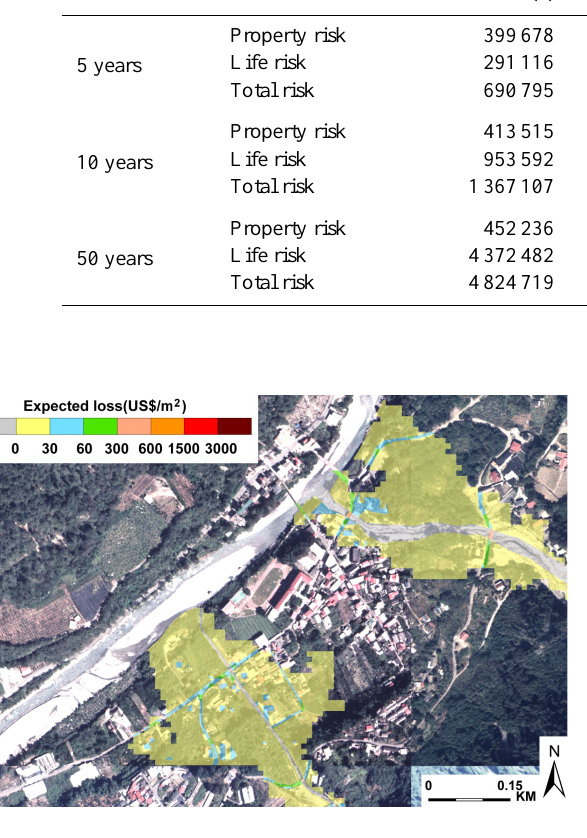
Fig. 4. Map showing the spatial distribution of expected property loss caused by debris flows of the Nos. 1 and 2 Torrents for an event with 50-year return period.